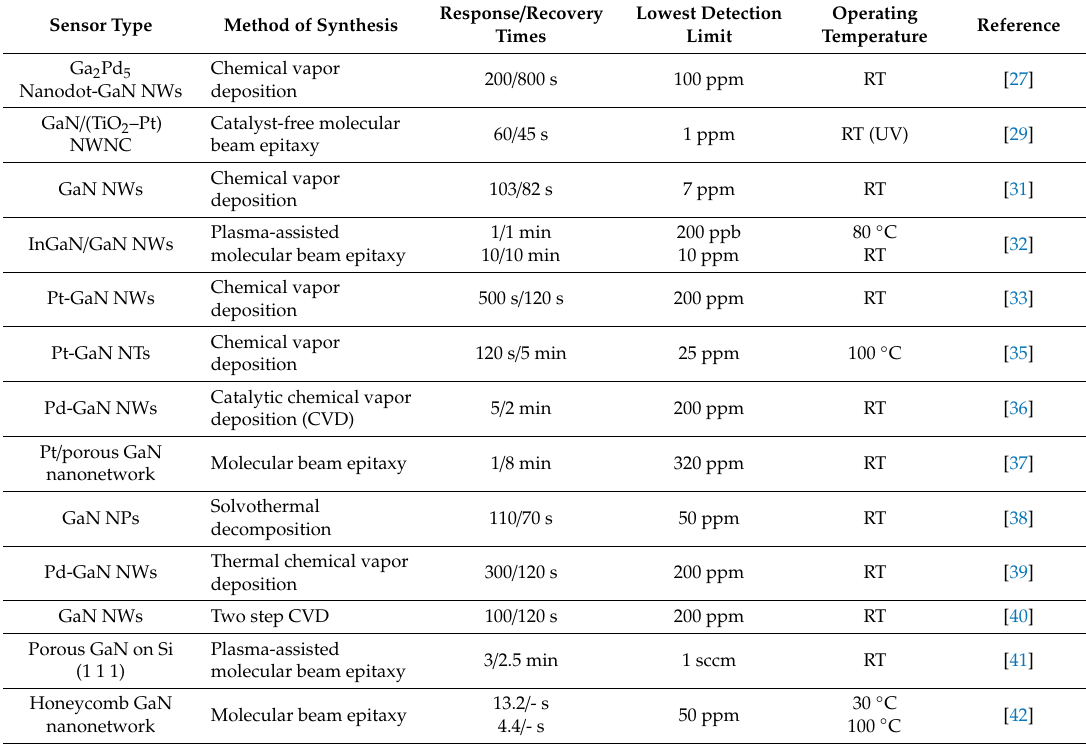
Table 1. Synthesis and sensing properties of GaN nanostructures based H 2